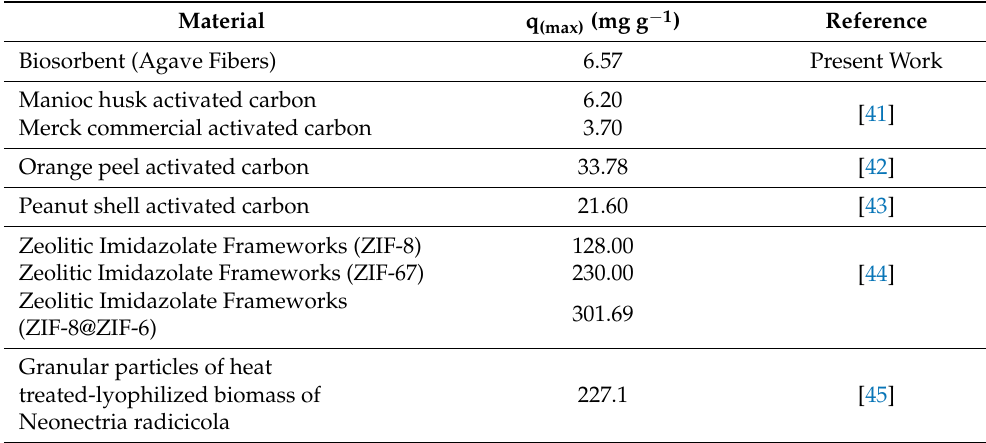
Table 5. Comparison of adsorption capacities of DB-86 in aqueous solution on different adsorbent